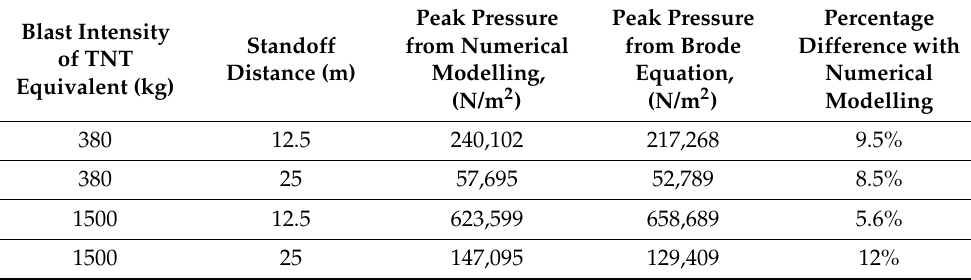
Table 3. Comparison between blast pressures from numerical and analytical